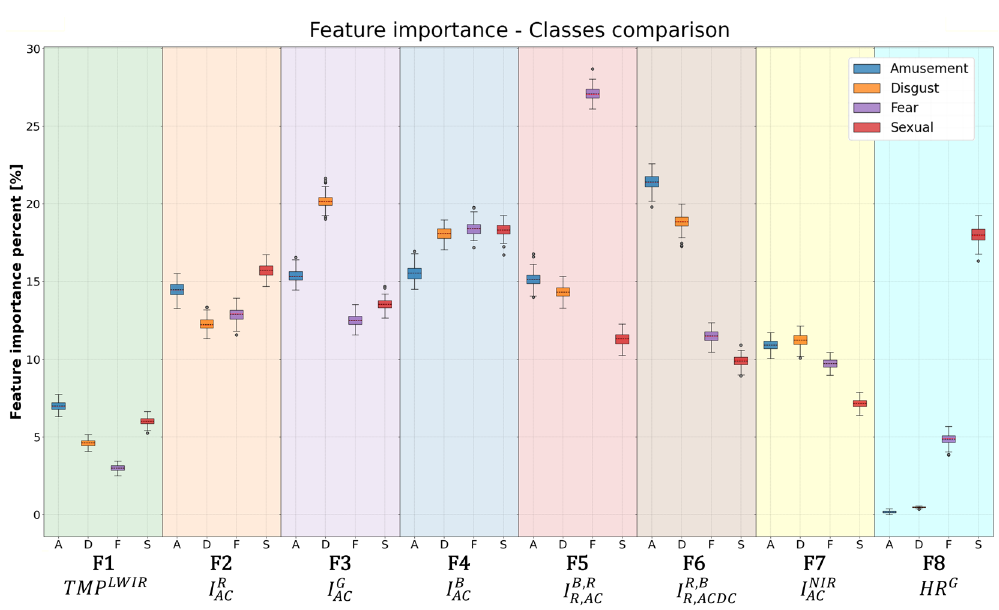
Figure 6. Feature importance of each constructed feature, per emotion class, classified vs. the baseline